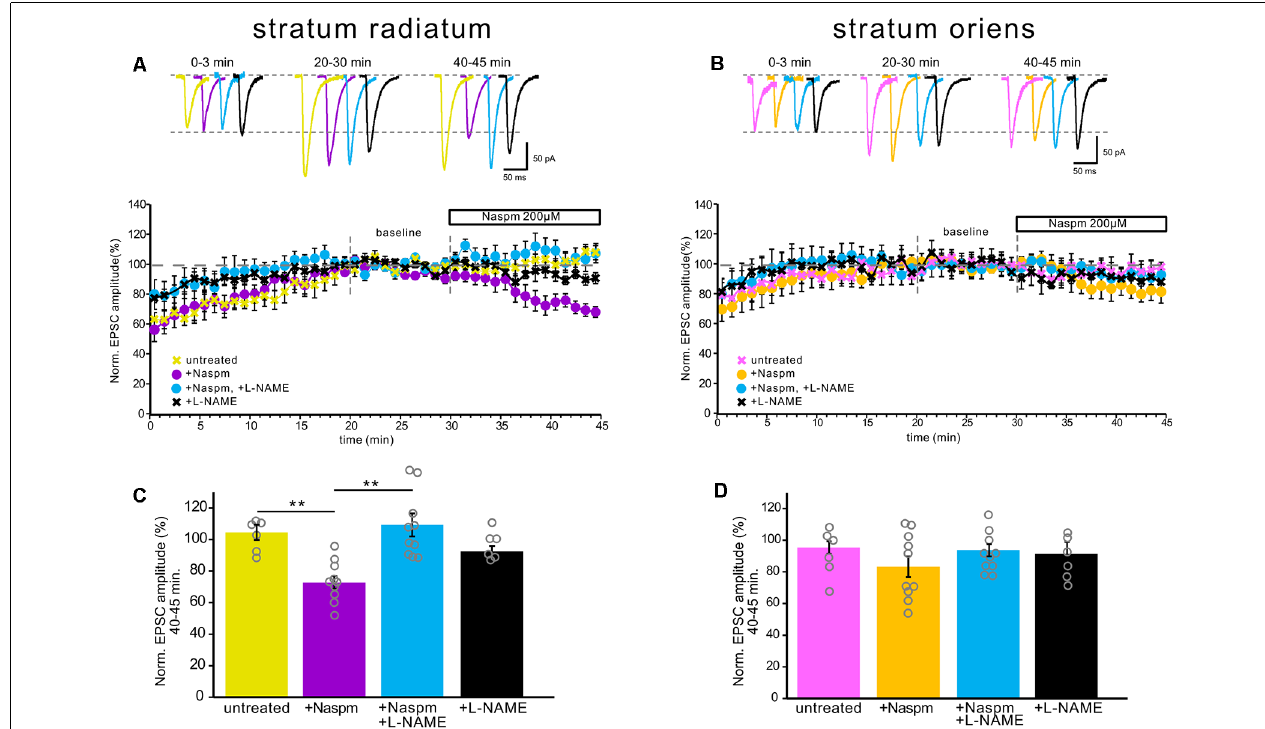
FIGURE 4 | NOS inhibition prevented CP-AMPAR current blockade by Naspm in the apical dendrites, but not in the basal dendrites. (A) The time course of EPSC amplitude changes in apical inputs during washout of polyamine (yellow, n = 6 cells from five animals), Naspm (200 µ M) application (purple, n = 10, eight animals), and under NOS inhibition (black, n = 6 cells from four animals) and under NOS inhibition with Naspm application (blue, n = 10 cells from eight animals). For analysis, 10 successive responses were averaged and normalized to the mean EPSC amplitude obtained between 20 and 30 min of the recording session (baseline marked with gray dashed lines). Top, example traces. (B) The same time course as (A) but for basal inputs. Pink, untreated cells, n = 6 cells from five animals. Yellow, cells treated with Naspm, n = 10 cells from eight animals. Blue, cells treated with L-NAME and Naspm, n = 10 cells from eight animals. Black, cells treated with L-NAME, n = 6 cells from four animals. Top, example traces. (C,D) Histograms demonstrating normalized EPSCs for the last 5 min of the curves A and B, respectively. Open gray circles represent individual data points, ** p ≤